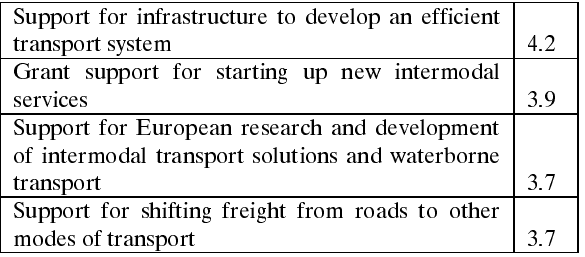
Table 3. Financing instruments relevant to supporting start-up of cooperation with the same type of business companies Support for infrastructure to develop an efficient